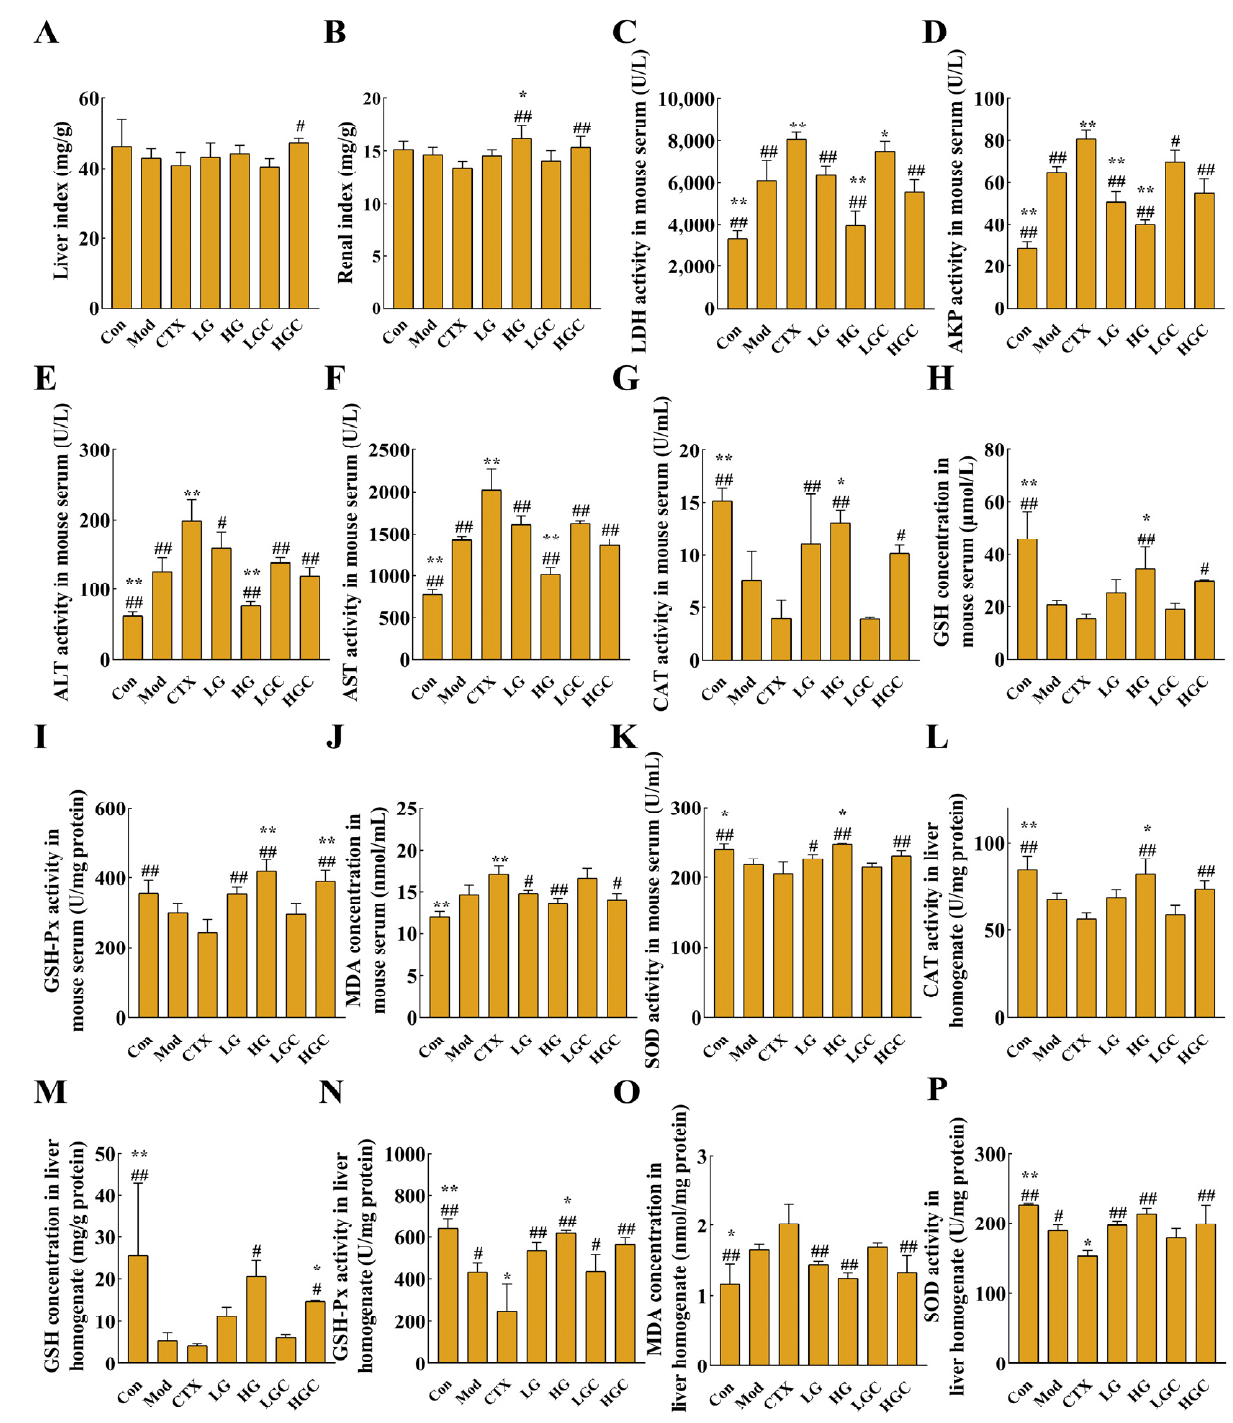
Figure 5. GFG relieved the side effects induced by CTX. ( A , B ) Liver and renal indexes of mice in different groups. ( C – F ) Changes of liver damage indicator. ( G – K ) Changes of oxidative damage indicators (the activities of GSH-Px, CAT, SOD and contents of MDA and reduced GSH in serum) in serum. ( L – P ) Changes of liver damage indicator (the activities of GSH-Px, CAT, SOD and contents of MDA and reduced GSH in liver tissues) in liver tissues. Data were expressed as the mean ± SD. * p < 0.05 and ** p < 0.01 versus the Mod group; # p < 0.05 and ## p < 0.01 versus the CTX group.